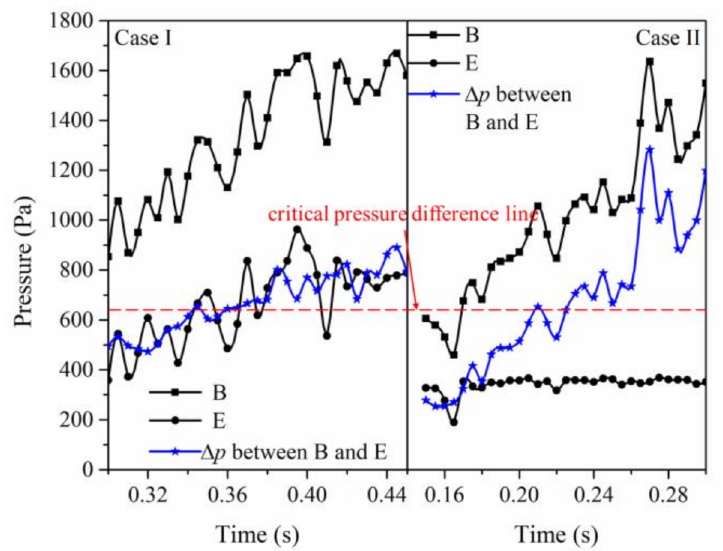
Figure 7. Variation of water phase pressure near the oil–water interface with time when oil–water interface starts to move in case I (continuous injection) and case II (continuous injection) (square-line: water pressure near interface B; circle-line: water pressure near interface E; star-line: water pressure difference between B and